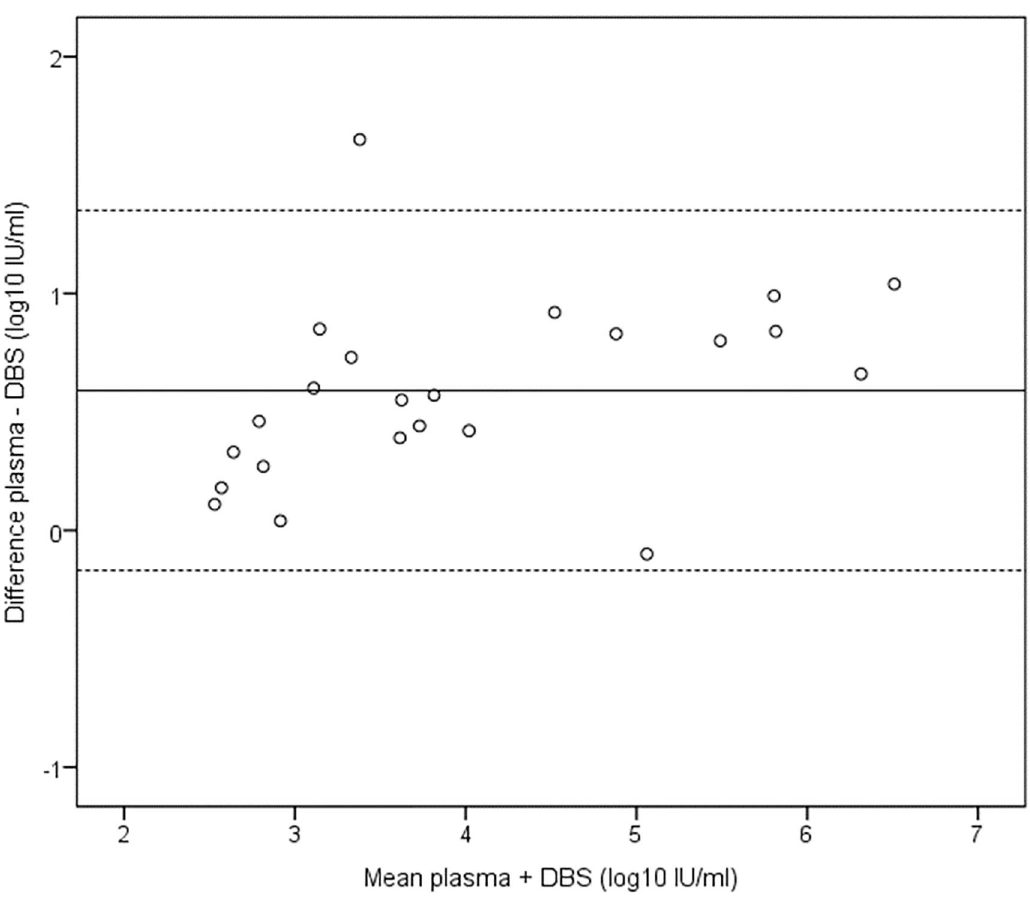
Fig 2. Bland and Altman analysis of agreement between HBV DNA levels in 23 paired plasma and Dried Blood Spot (DBS) specimens. The horizontallines represent the mean difference (continuous line) and +/- 1.96 standard deviations(dotted